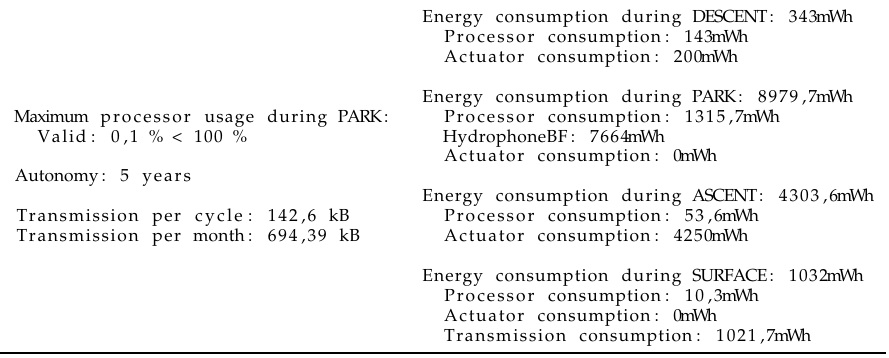
Figure 8. Analysis results given to the developers by